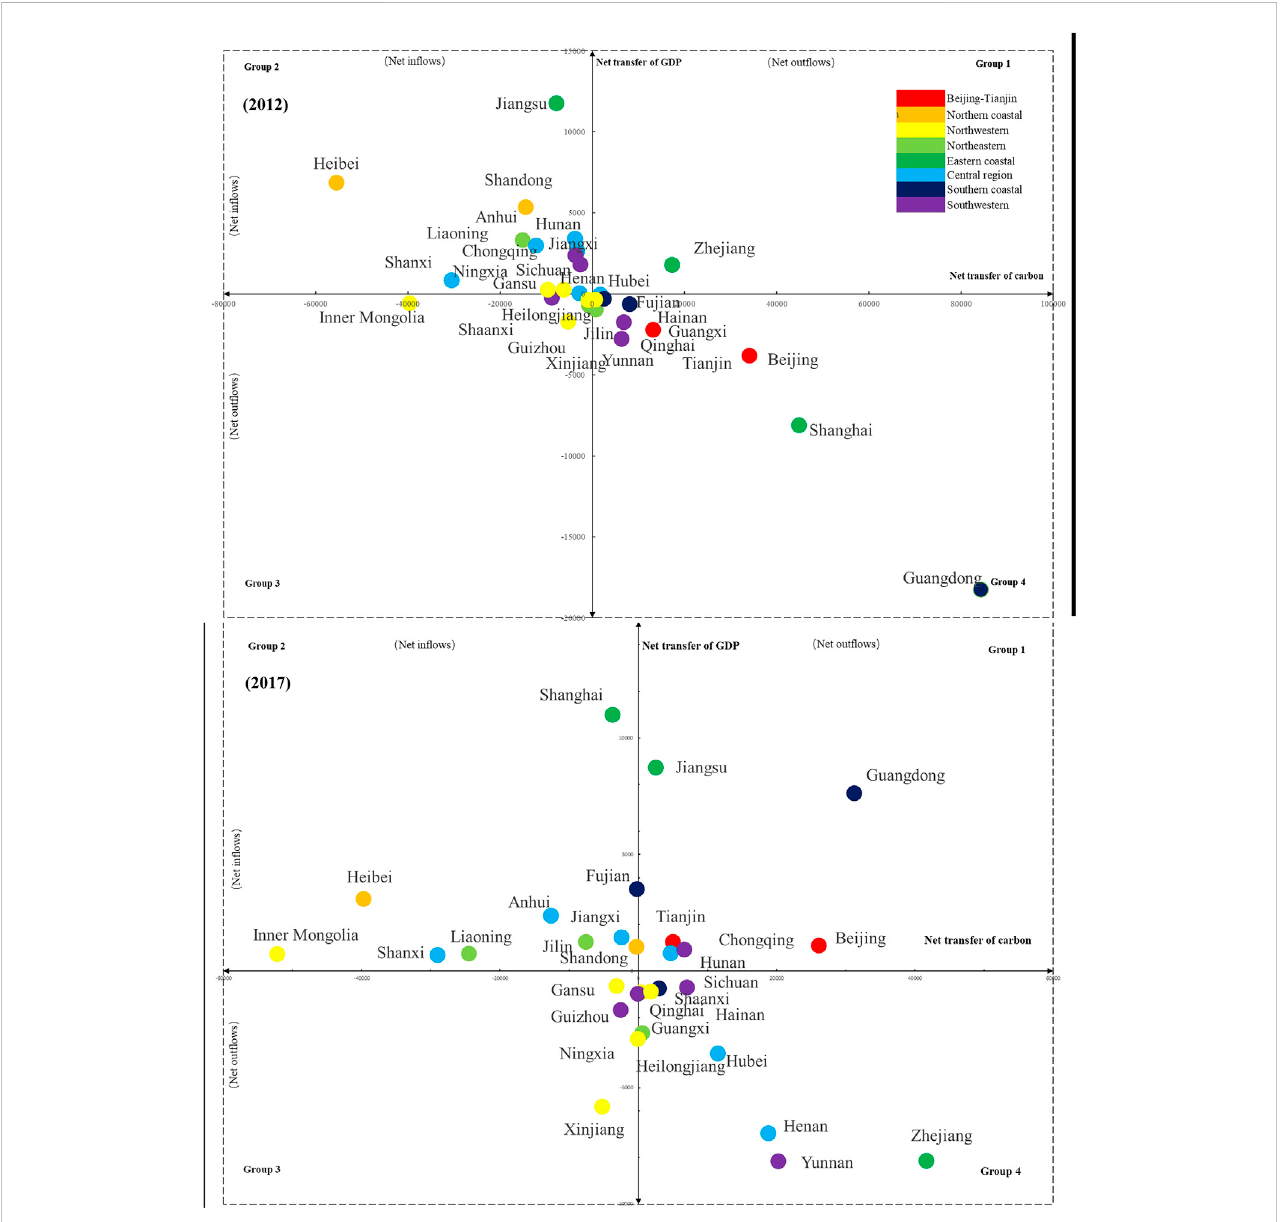
FIGURE 7 Net transfer relationships between embodied carbon and embodied GDP in inter-provincial trade from 2012 to 2017.